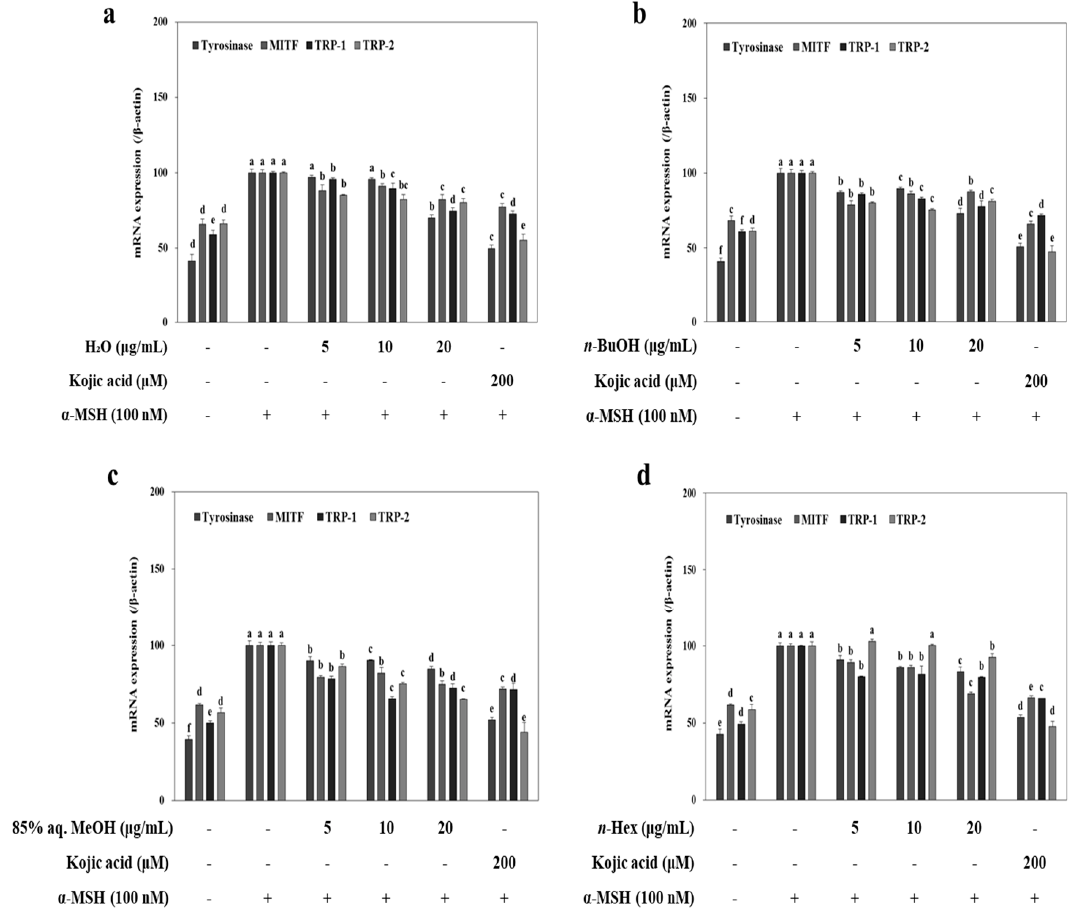
Figure 3. Changes in expression of tyrosinase, MITF, TRP-1, and TRP-2 mRNA levels in L. tetragonum solvent-partitioned fractions ( a : H 2 O; b : n -BuOH; c : 85% aq. MeOH; d : n -Hexane) and Kojic acid treated B16-F10 cells. a–e Means with the different letters are significantly different ( p < 0.05) by Duncan’s multiple range test among same samples compared to control group.